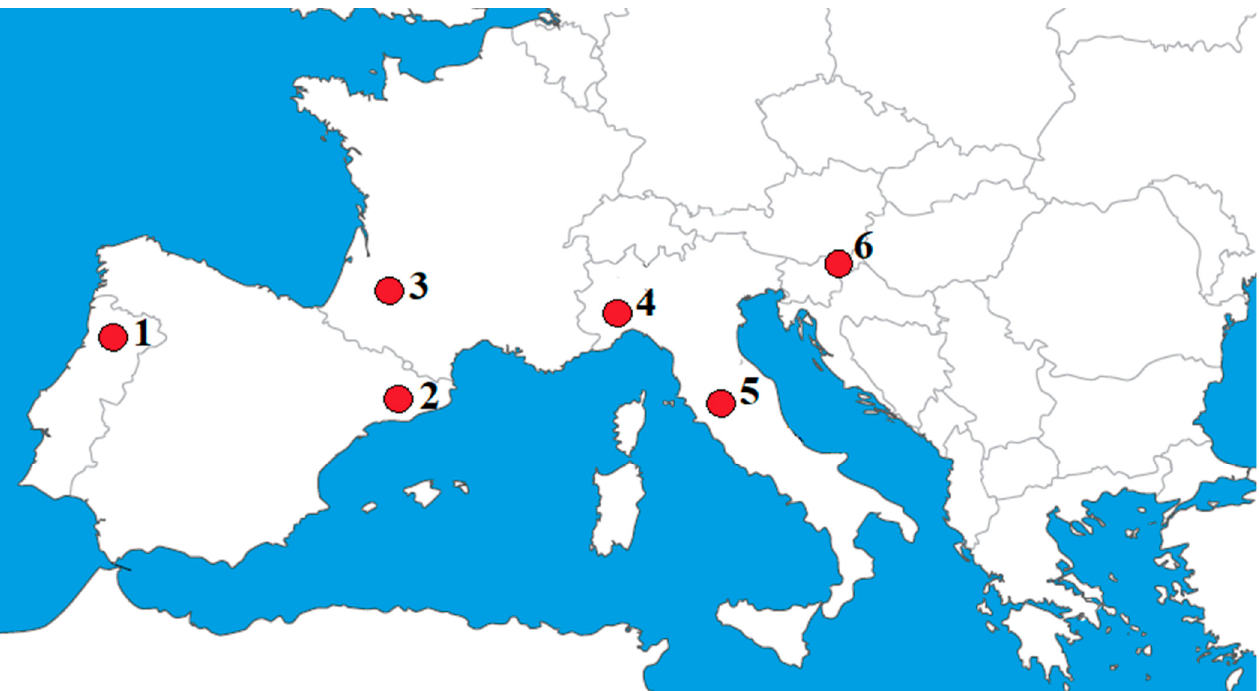
Figure 3. Locations of hazelnut sampling for the phenolic analysis: 1—Vila Real, Portugal (PTG); 2—Constanti, Spain (SPA); 3—Puéchoursi and Montesqieu, France (FRA); 4—Cravanzana, Italy (ITN); 5—Viterbo, Italy (ITS); 6—Maribor, Slovenia (SLO).